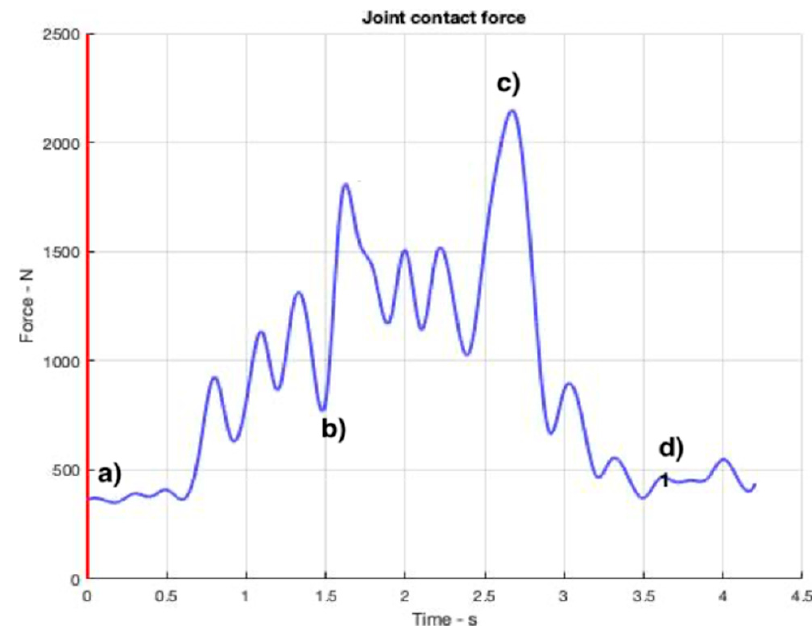
Figure 9. Joint contact force values for compression at the L5 ‐ Pelvic throughout the OTP. The instants corresponding to the four snapshots in Figure 6 are indicated from ( a – d ).